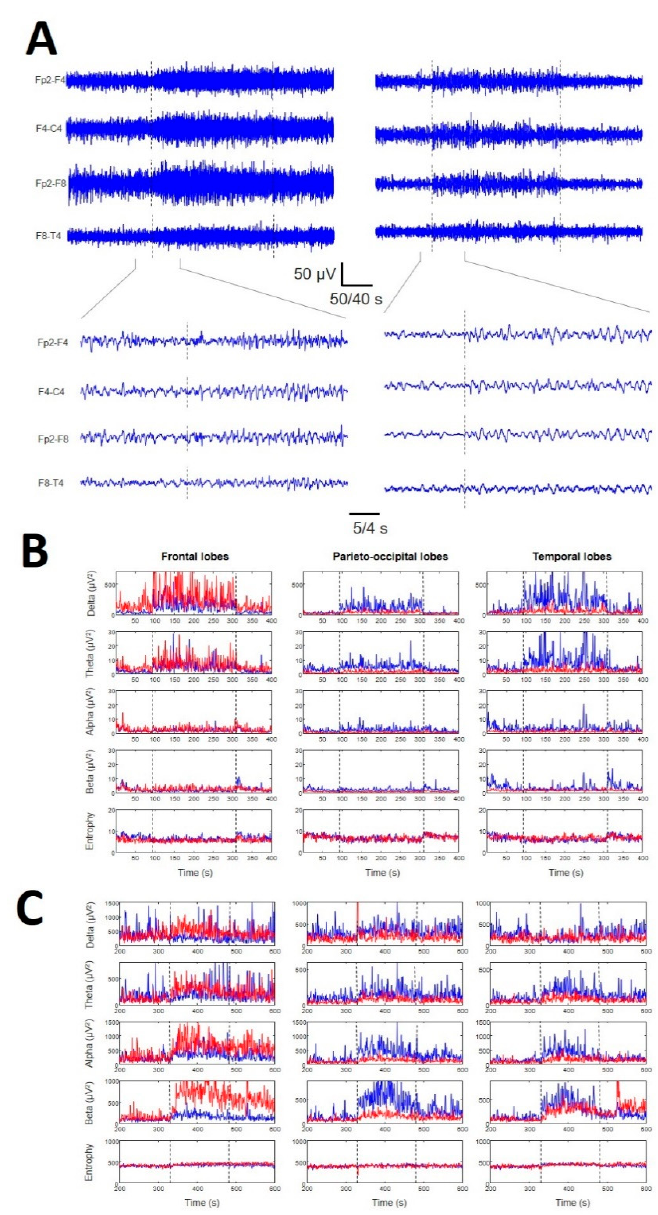
Figure 1. Examples of paroxysmal activity recorded in critically ill patients. ( A ) Left column: recordings from the right frontal lobe of a patient suffering a generalized seizure (GS). Right column: recordings from the same channels of a patient suffering a BPA. Traces are expanded below. Time-base is different for every recording. ( B ) Dynamics of bands (rows) and Se (lower row) for different lobes (columns) from the BPA above. ( C ) Dynamics of bands (rows) and Se (lower row) for different lobes (columns) from the GS above. Paroxysmal activity is indicated by vertical dotted lines. Red: right hemisphere. Blue: left hemisphere.